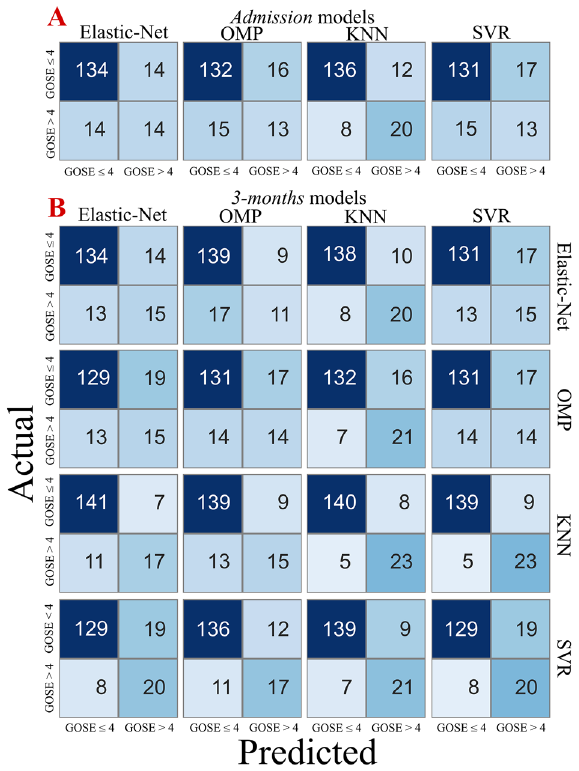
Figure 2. Confusion matrices of classification: predicted values were reported on the x-axis while actual values on the y-axis. In the upper part ( A ), the confusiom matrices of the four admission models were reported. In the lower part results after the 3-months adaptation of each approach were compared ( B ). All 4 × 4 possible combinations of classifiers were compared: for each of the columns, models built using the prediction of admission model on top were